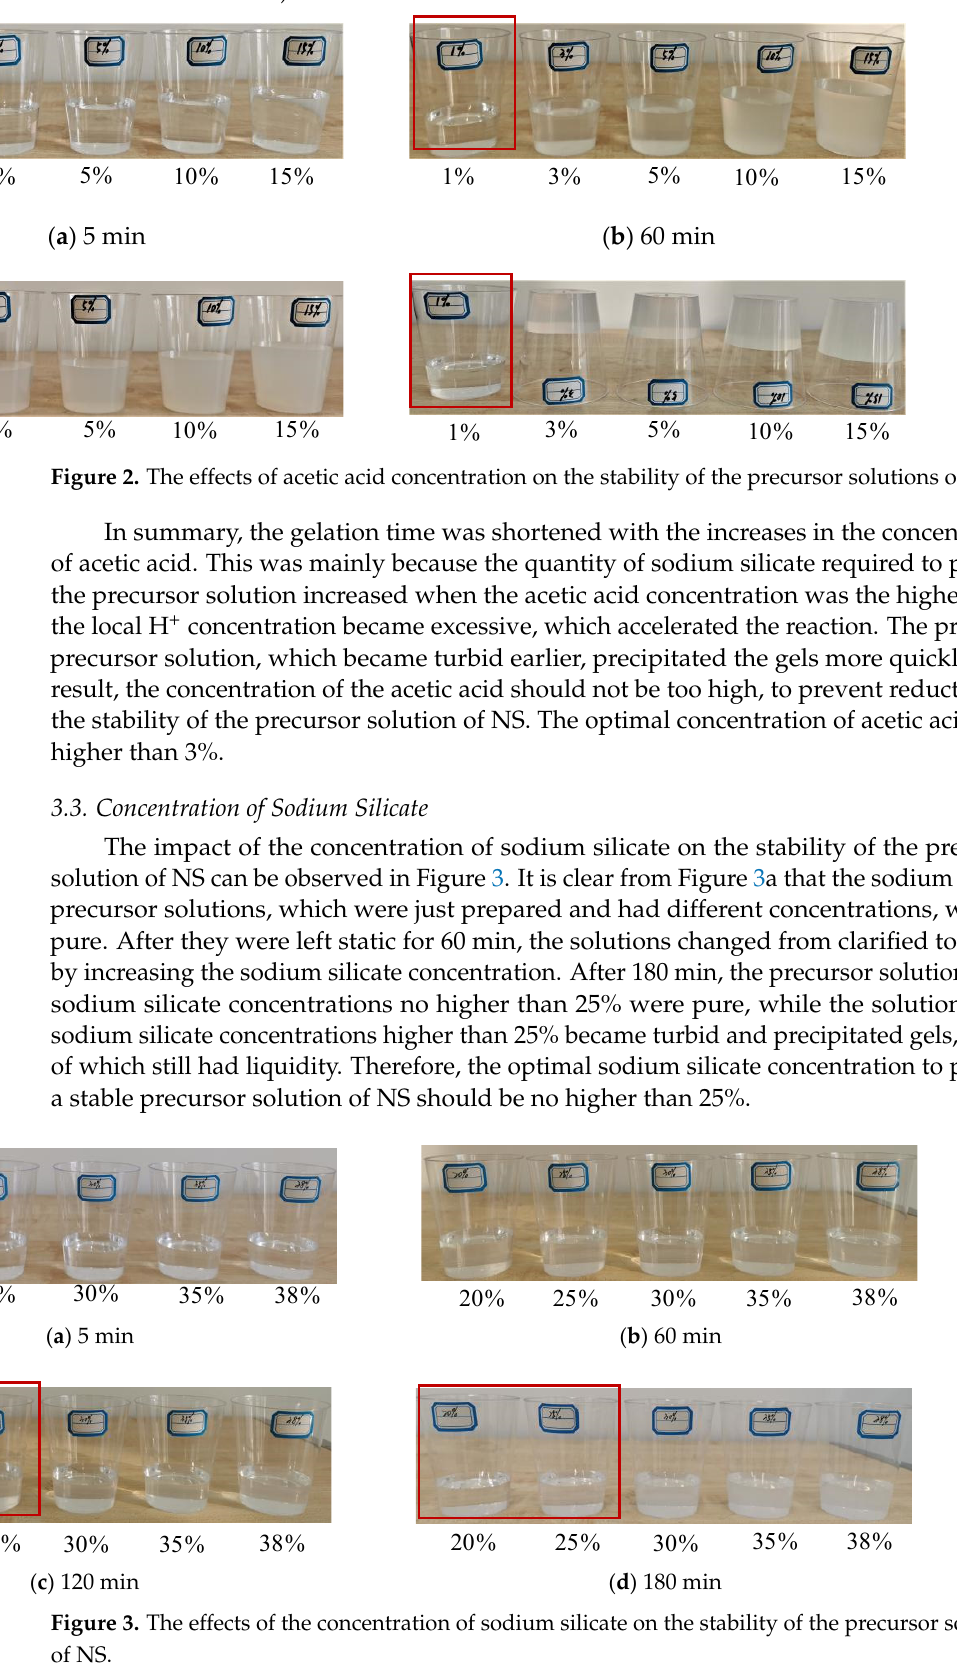
( d ) 180 min Figure 4. The effects of pH value on the stability of precursor solutions of NS. The precursor solutions at the pH values of 7 and 8 could precipitate gels quickly, gradually reaching complete gel integrity without any liquidity. The precursor solutions at the pH values of 4 and 5 did not exhibit any evident changes within 180 min, without obvious turbidity and no production of gels. The precursor solution at a pH value of 6 was pure and then became turbid within 180 min, while it remained a liquid; however, there was some gel precipitation. Therefore, the optimal pH value for the precursor solu- tion was determined to be no higher than 6, which was used as the stable pH value to prepare the precursor solution of NS. A stable precursor solution of NS can be prepared by using the optimum acid media and its relevant concentrations, an optimum sodium silicate concentration, and the corre- sponding optimal pH value for the precursor solution. This lays a foundation for analyz- ing the precipitation conditions for NS precursors in alkaline solutions and for further dis- cussing the precipitation morphologies for a precursor solution of NS in cement paste, as well as the EDS of the mixture.